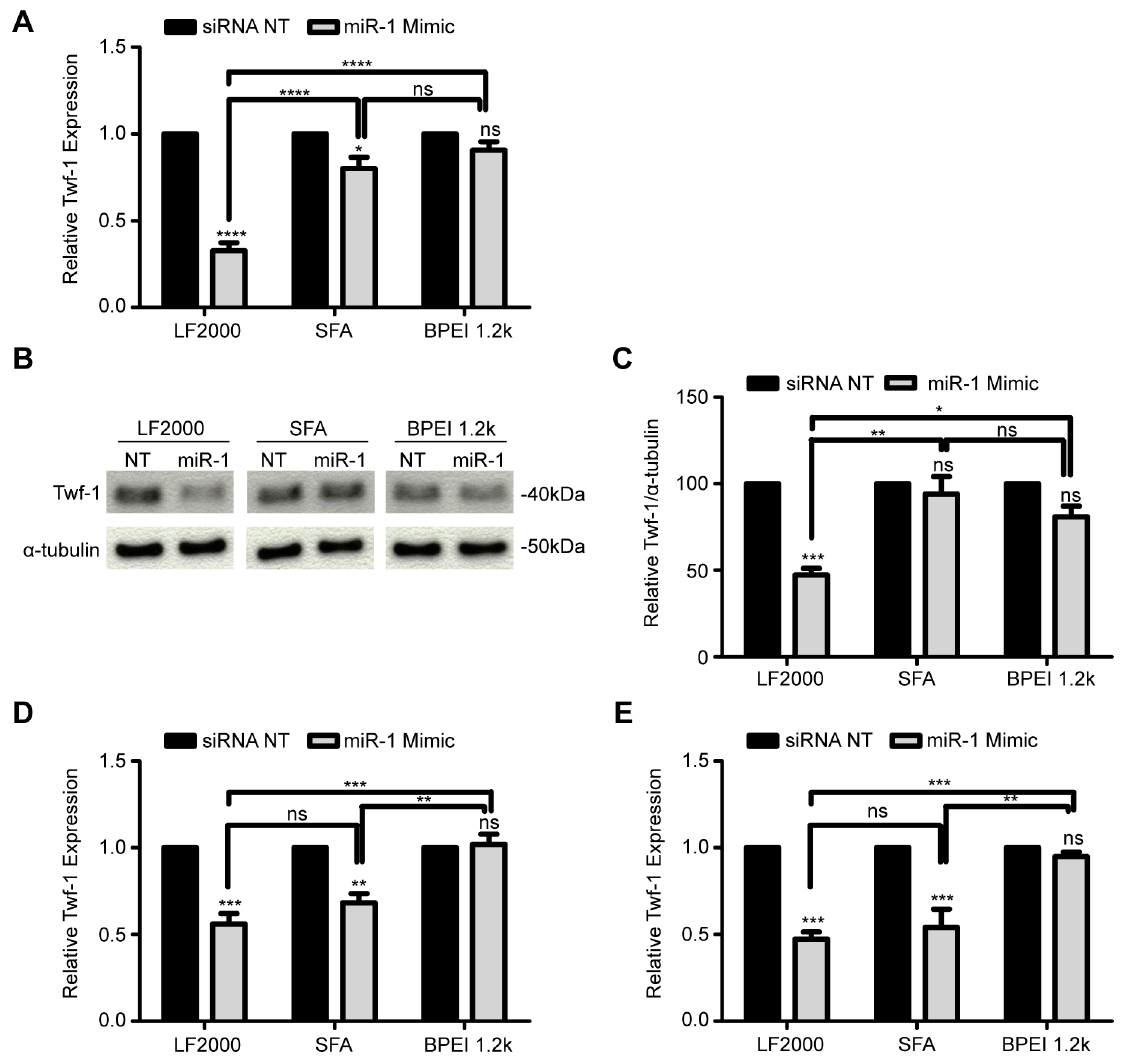
Figure 4. Lipid-based miRNA transfection is an effective method for targeted gene regulation in preadipocytes and adipocytes. SGBS preadipocytes were transfected with nontargeting (NT) siRNA and a miR-1 mimic with Lipofectamine 2000 (LF2000), ScreenFect A (SFA) or BPEI 1.2 k as delivery agents. (A) The levels of miR-1 target twinfilin-1 (twf-1) mRNA were determined with qPCR 48 hours post-transfection. (B) Protein samples were extracted 48 h after transfection and twf-1 protein levels assayed via western blotting and quantified using Image J software (C). 30 m g of protein was loaded in each lane. Equal loading was ensured by a -tubulin expression. SGBS adipocytes (D) and primary human adipocytes (E) were transfected with NT siRNA and miR-1 mimic with LF2000, SFA or BPEI 1.2 k. The levels of miR-1 target twinfilin-1 (twf-1) mRNA were determined with real-time qPCR 48 hours post-transfection. Experiments were carried out three times independently and the results are reported as mean and SEM. ****p , 0.0001 and *p , 0.0274 in (A), ***p , 0.0007 LF2000 siRNA NT vs. miR-1, **p , 0.0018 LF2000 vs. SFA and *p , 0.0213 LF2000 vs. BPEI in (C), ***p , 0.0002 LF2000 siRNA NT vs. miR-1, ***p , 0.0006 SFA siRNA NT vs. miR-1, ***p , 0.0005 LF2000 vs. BPEI and **p , 0.0016 SFA vs. BPEI in (D), ***p , 0.0004 and **p , 0.0060 in